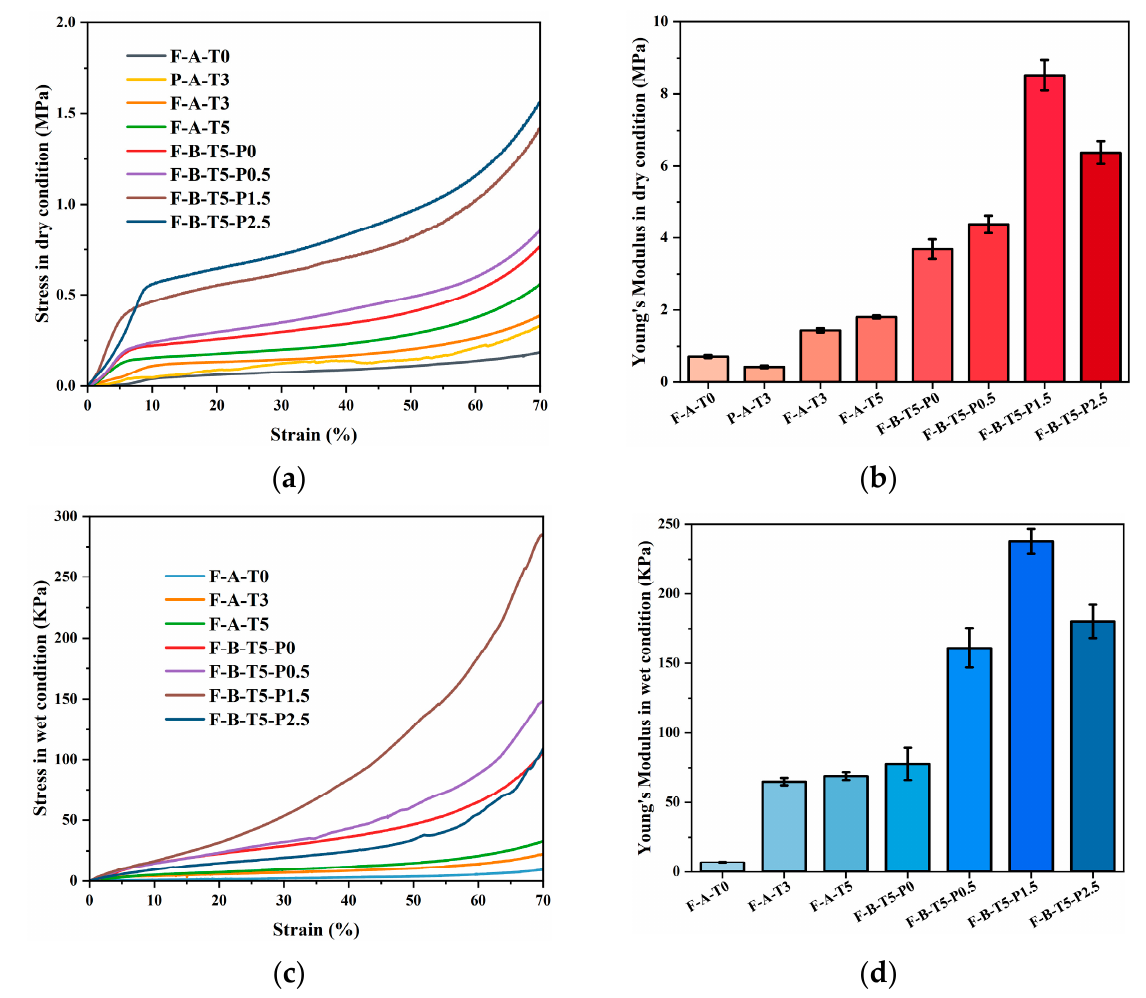
Figure 5. Compressive strength. ( a ) The compressive stress–strain curve in dry conditions. ( b ) Young’s modulus in dry conditions. ( c ) The compressive stress–strain curve in wet conditions. ( d ) Young’s modulus in wet conditions.